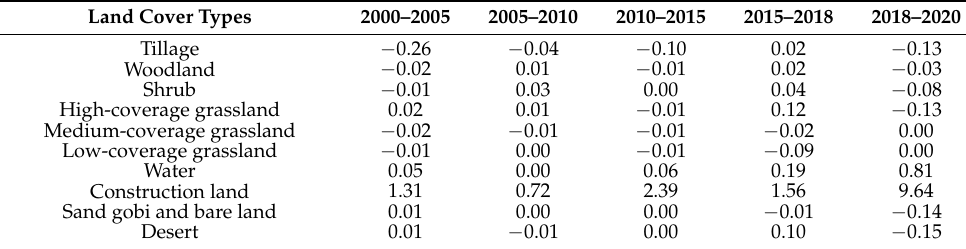
Table 3. Annual change rate (%/a) of land covers in the TP. Land Cover